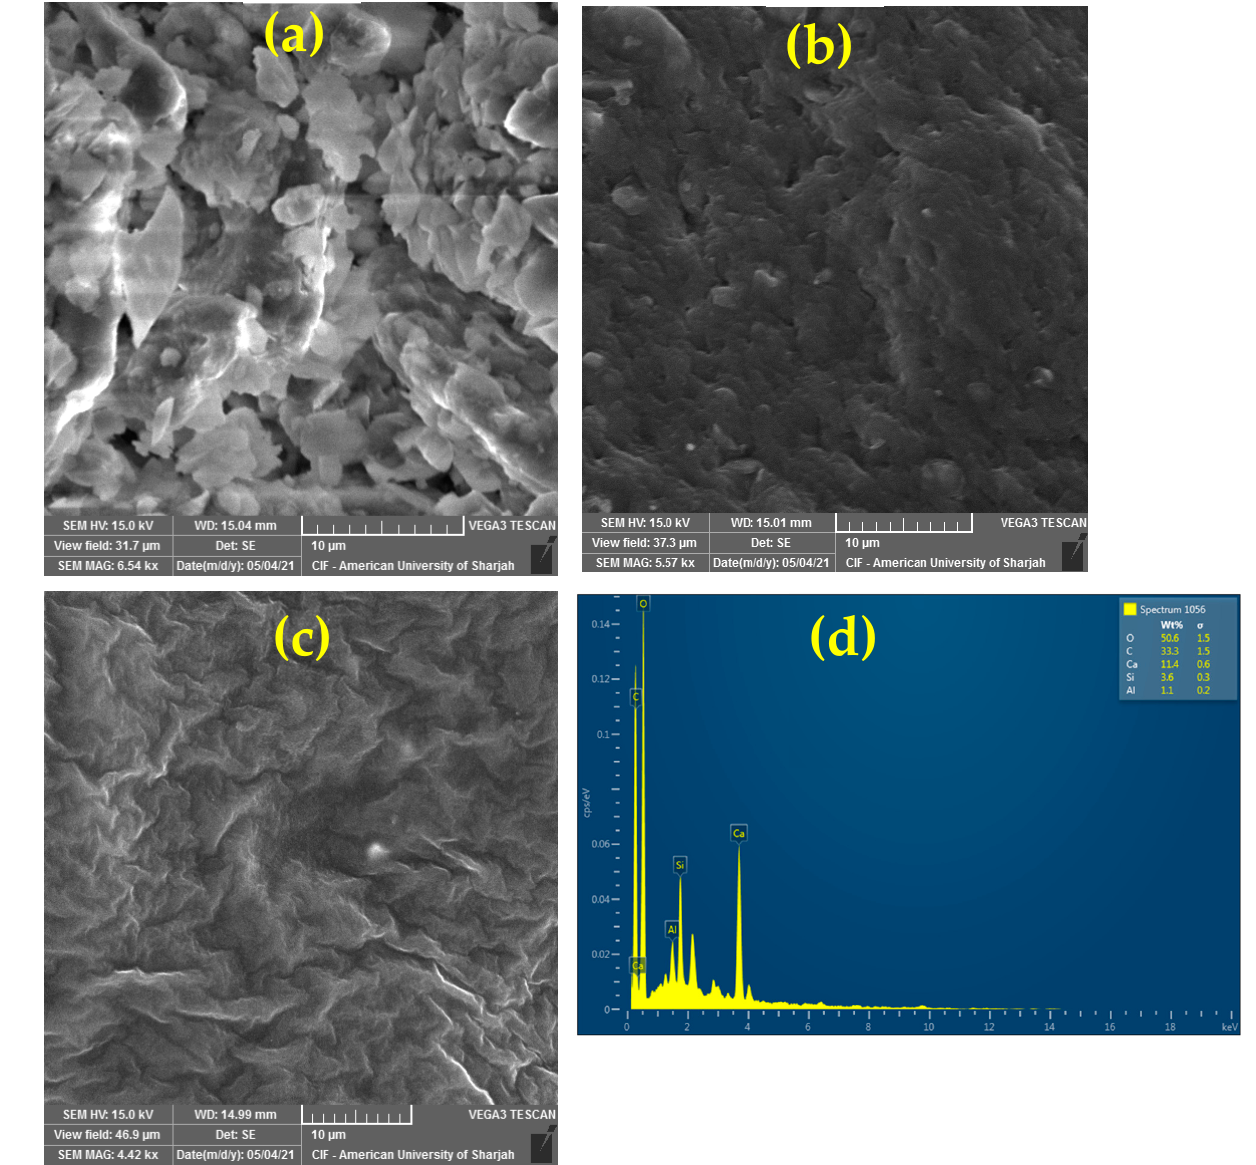
Figure 3. SEM images of the clay-alginate-ILs beads with different magnifications ( a ) 31.7 µm, ( b ) 37.3 µm, ( c ) 46.9 µm ( d ) EDX analysis of the clay-alginate-IL beads.